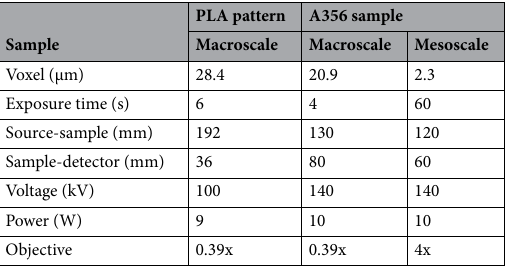
Table 2. X-ray μCT